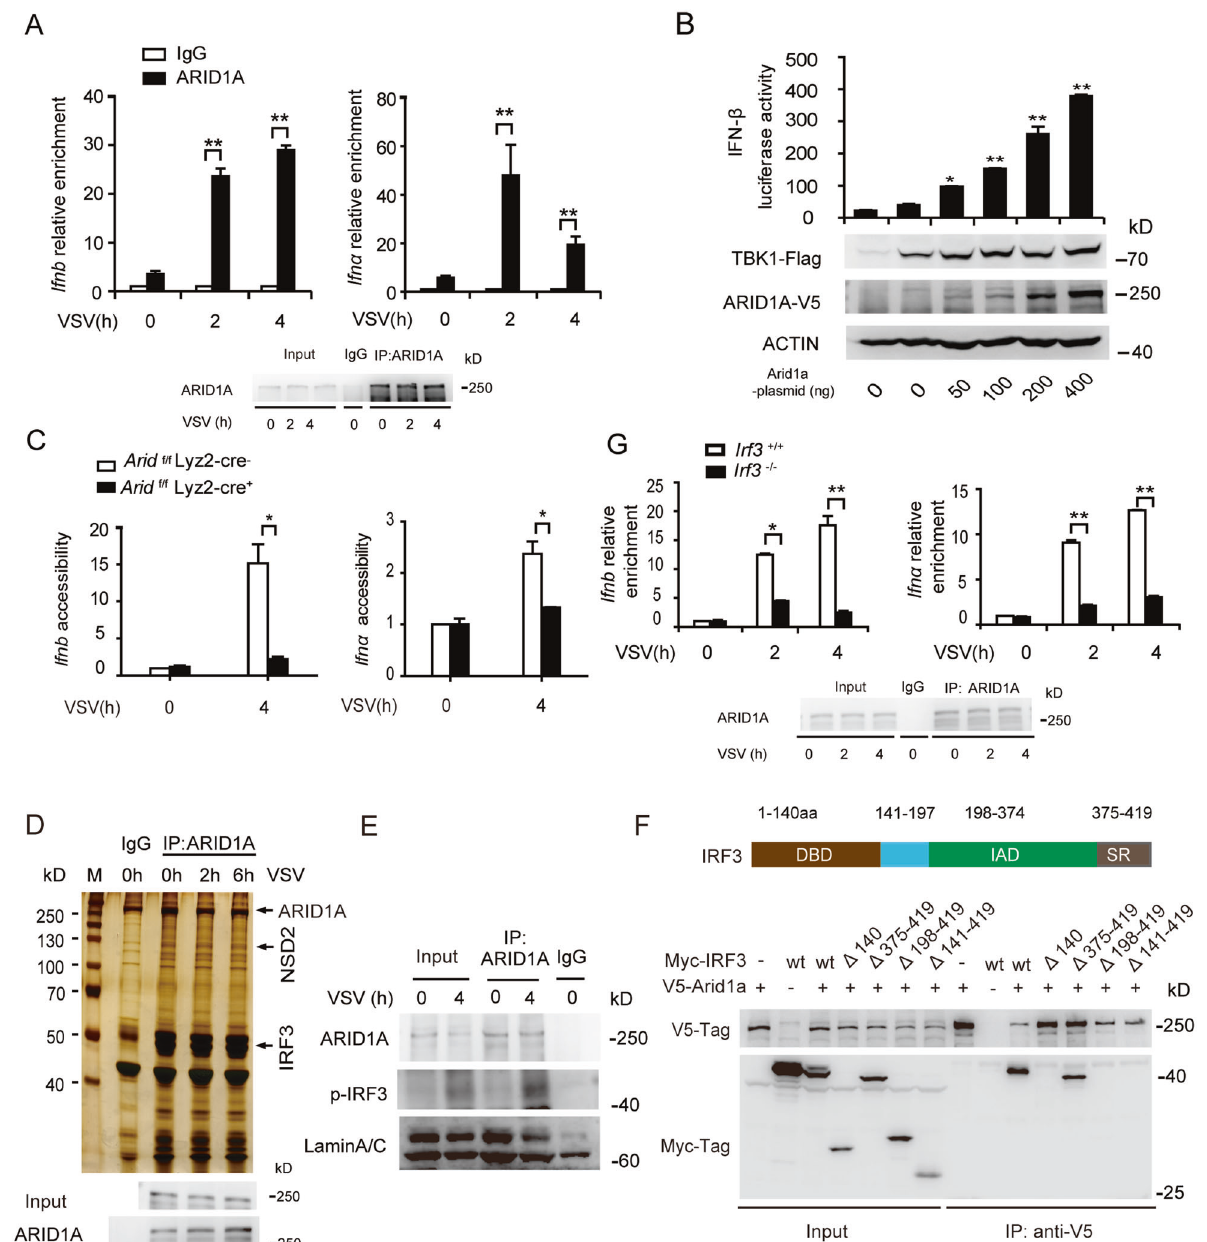
Fig. 3 ARID1A is recruited by IRF3 to Ifn-I promoters to increase chromatin accessibility. A ChIP analysis of ARID1A recruitment to the promoter regions of Ifn-I in macrophages infected with VSV (MOI, 1) at indicated times (up panel) and immunoblot analysis of ARID1A expression in ChIP samples (down panel). B Luciferase assay of Ifnb reporter activity in HEK293T cells transfected with pcDNA3.1-Tbk1-Flag and PEF1a-V5-Arid1a with gradually increased concentrations (upper panel) and immunoblot analysis of ARID1A and TBK1 expression in transfected cells (lower panel). C DNA accessibility assay of the Ifn-I promoter regions in Arid1a f/f Lyz-Cre − and Arid1a f/f Lyz-Cre + BMDMs infected with VSV (MOI, 1) at the indicated times. D Silver staining of the proteins immunoprecipitated in the BMDM lysates by ARID1A antibody (up panel) and immunoblot analysis of ARID1A expression in IP samples (down panel). E Co-IP analysis of the interaction between endogenous ARID1A and p-IRF3 in the nucleus of BMDMs infected with VSV (MOI, 1) at the indicated times. F Co-IP analysis of the interaction between tagged ARID1A and wild type IRF3 or indicated IRF3 mutants in HEK293T cells. G ChIP assay of ARID1A recruitment to the promoter regions of Ifn-I in Irf3 + / + and Irf3 − / − BMDMs in response to VSV infection (MOI, 1) (up panel) and immunoblot analysis of ARID1A in ChIP samples (down panel). Error bars represent s.d. Student ’ s t -test. * P < 0.05, ** P < 0.01. All data are representative of three independent experiments with three biological replicates. ( A – C , G : mean ±